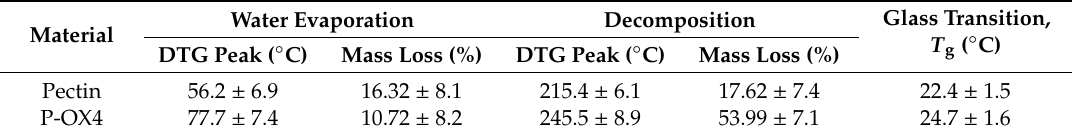
Table 2. Thermogravimetric analysis (TGA) results obtained for P-OX4 derivatives ( n = 3, ± SD).